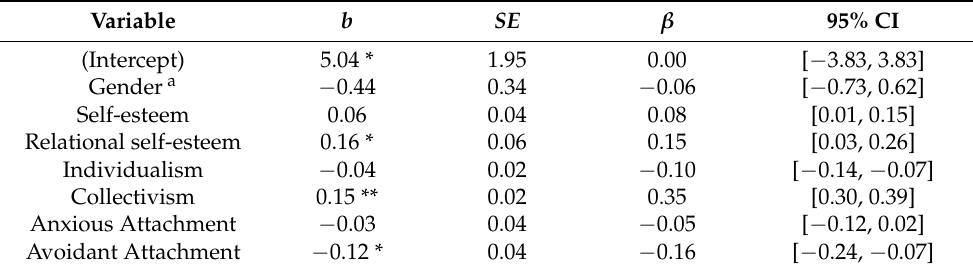
Table 5. Regression Coefficients of Study Variables on External—Peer